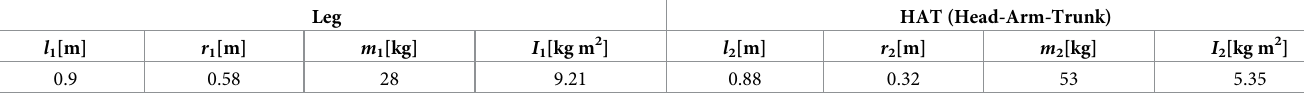
Table 1. Anthropometric parameters of the DIP model.